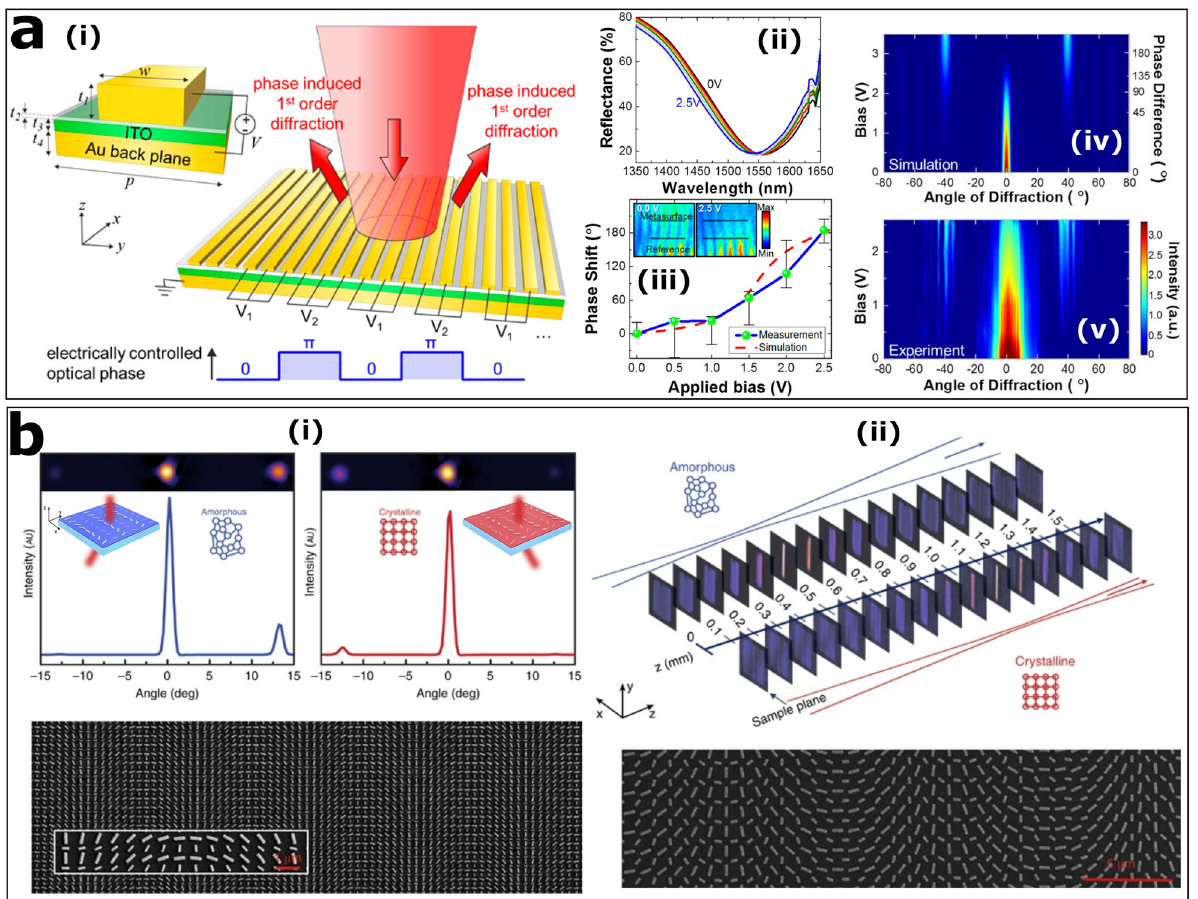
Figure 5: ITO-based and GST-based tunable metasurfaces. (a): (i) Schematic of the gate-tunable metasurface. (ii) Measured reflectance spectrum from the metasurface for different applied bias. (iii) Measured and simulated phase shift as a function of applied bias. (iv) Simulated and (v) experimental measured far- fi eld intensity pro fi les of the diffracted beam versus applied bias. Reproduced with permission from ref. [124]. Copyright 2016, American Chemical Society. (b): (i) Tunable plasmonic metasurface for beam switching. Top: Infrared camera images and intensity plots of the beam transmitted by the metasurface in the amorphous (left) and crystalline (right) state. Bottom: SEM image of the metasurface. Scale bar: 1 µm. (ii) Tunable plasmonic metasurface for bifocal zoom. Top: Camera pictures of the cylindrical bifocal lens imaged at different distances z . Bottom: SEM image of the metasurface. Scale bar: 5 µm. Reproduced from ref. [116] under a Creative Commons Attribution-NonCommercial-NoDerivs 4.0 International License,